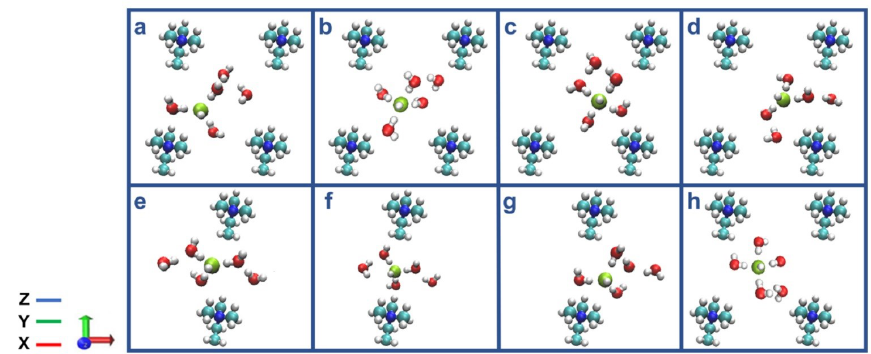
Figure 6. The detailed z-axis illustration of vehicular diffusion mechanism steps ( a – h ). Representative configurations showing the vehicular diffusion for the simulated system from a z-axis perspective, in the center of the cell ( a – d ) and in the bottleneck region ( e – h ), including five water molecules from the first and second solvation shells. Red, white, turquoise, and blue spheres represent O, H, C, and N atoms, respectively. A green sphere represents the hydroxide ion. ( a ) A hydroxide ion is in a stable threefold structure near a cation, with two water molecules in the second solvation shell. ( b ) The hydroxide ion is in a fourfold planar structure in the center of the cell, with one water molecule in the second solvation shell. ( c ) The hydroxide ion and the five water molecules move toward the nearby cation. ( d ) The hydroxide ion is in a stable threefold structure near a cation. Two water molecules are located at neighboring bottleneck regions. ( e ) The hydroxide ion forms a stable OH ˘ ( H 2 O ) 4 complex, in which three water molecules are part of a threefold tetrahedral structure, and one water molecule is in the second solvation shell. A water molecule is located below the hydroxide ion in the bottleneck region. ( f ) The hydroxide ion and five water molecules are diffusing through the bottleneck region. ( g ) The hydroxide ion crosses the bottleneck region and is located near a cation in a stable threefold structure. ( h ) The hydroxide ion’s threefold structure changes back into a fourfold planar structure, as it diffuses toward the center of the cell. Reprinted with permission from [41]. Copyright 2019, for the American Chemical